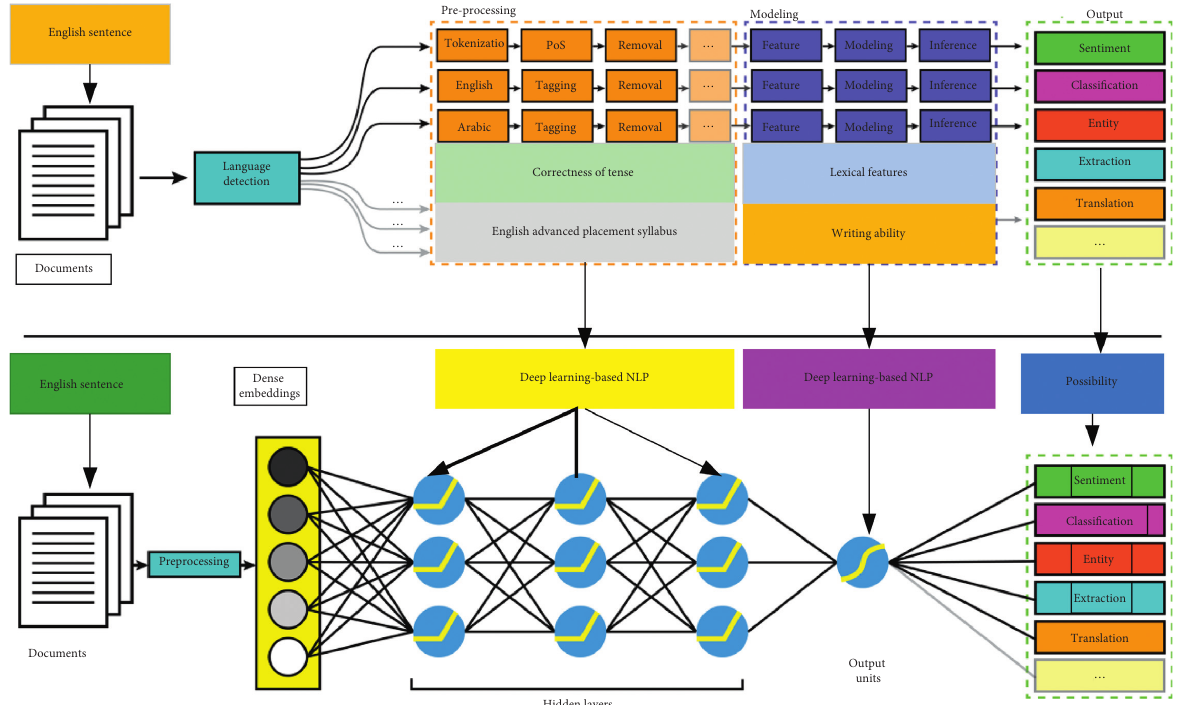
Figure 1: Natural language processing technology